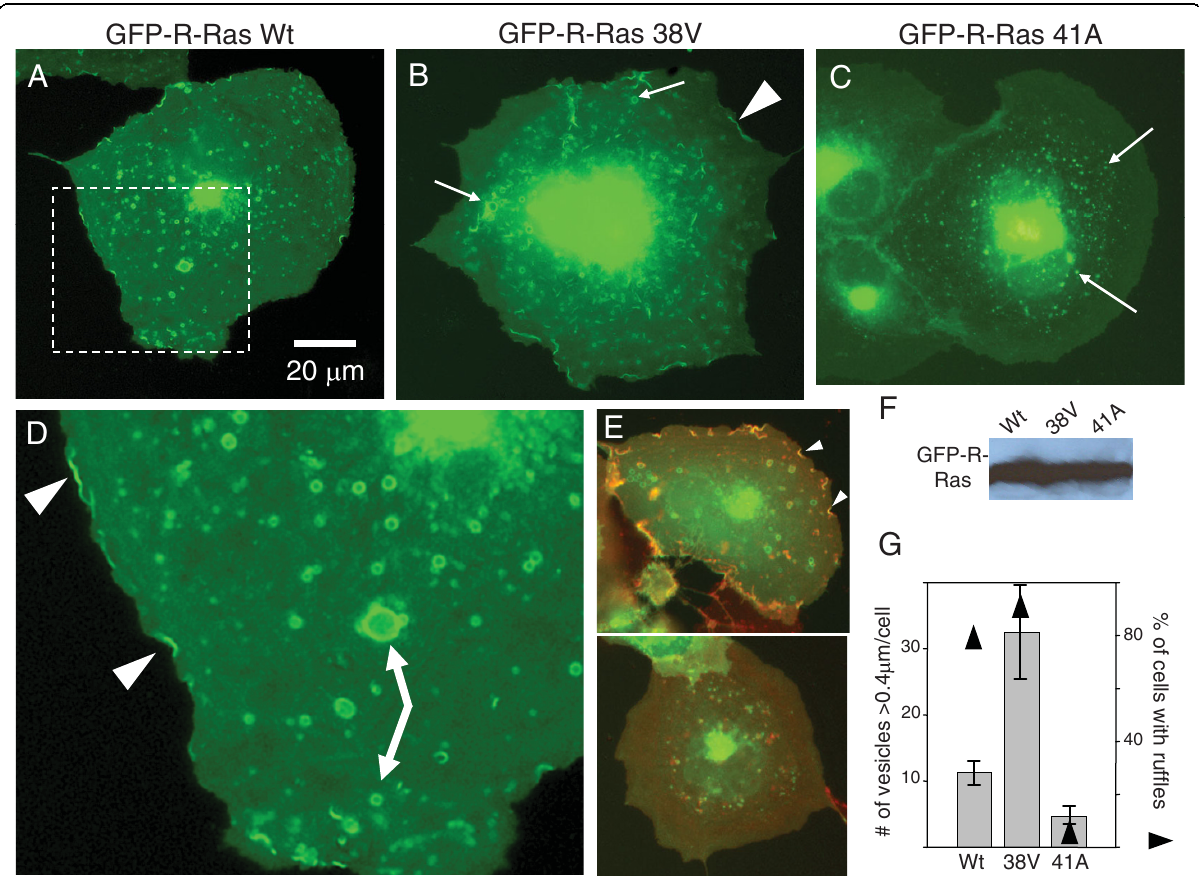
Figure 2 GFP-R-Ras localizes to discrete plasma membrane domains . Cos-7 cells were transfected with GFP-R-Ras constructs, and the localization of each to the plasma membrane determined. Plasma membrane localization was noted in 79% of GFP-R-Ras(wt) (A , n ≥ 100 cells for each) and in 91% of constitutively active GFP-R-Ras(38V) (B) but not in cells transfected with dominant negative GFP-R-Ras(41A) (C , < 5% of cells). In all three transfectants, there was a variable amount of perinuclear fluorescence which included small, dot-like vesicles positive for GFP-R- Ras (arrows in C). In addition, both wt and 38V-expressing cells contained medium- and large-sized vesicles ( ≥ 0.4 μ m). (D) 3× zoomed view of dashed box in (A) highlights the appearance of plasma membrane fluorescence (arrowheads) and the assortment of vesicle and endosomal compartment sizes (arrows). (E) A cell transfected with GFP-R-Ras(38V) was co-stained with 4 μ g/mL Alexa Fluor-555 cholera toxin B (top panel) to reveal co-localization of R-Ras with ganglioside-GM1 in ruffles (arrowheads). The lack of ruffle formation in GFP-R-Ras(41A) cells was independently confirmed by co-staining with cholera toxin B where ruffles were observed in 0 of the 26 cells imaged. (F) Western blot for GFP- R-Ras shows that protein levels were the same in GFP-R-Ras-(wt), -(38V) and -(41A) transfected cells in spite of the dramatic differences in localization of each isoform. (G) The number of endocytic compartments per cell was measured in >100 cells for each of the transfected constructs (bars). The percentage of cells that contained GFP-R-Ras localized to ruffles was quantified